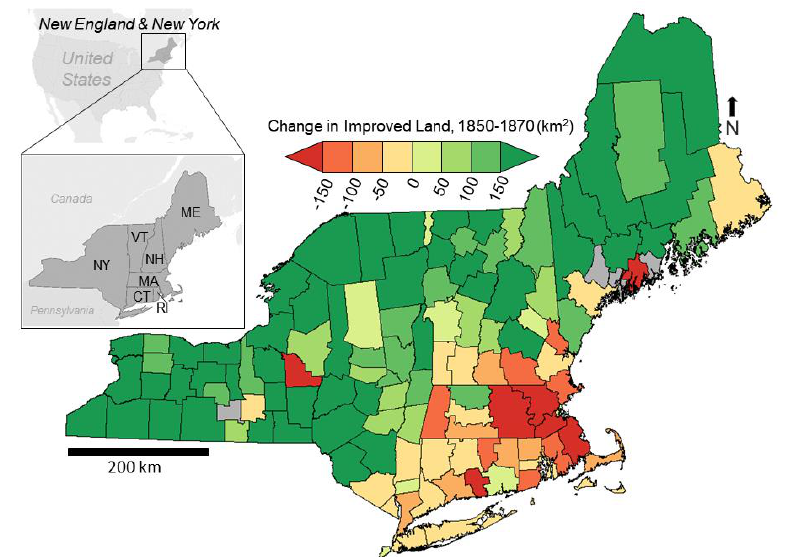
Figure 1. Change in improved land (km 2 ) in the northeastern U.S. by county, 1850–1870, compiled from U.S. Census Nonpopulation Schedule for Agriculture data [29,30]. This census recorded the amount of improved and unimproved farmland at the town level beginning in 1850. Counties in gray did not exist in 1850 and therefore continuous data are not available. Map projection is NAD 1983 UTM Zone 18N. Abbreviations for states in the inset map are as follows: CT, Connecticut; MA, Massachusetts; ME, Maine; NH, New Hampshire; NY, New York; RI, Rhode Island; VT, Vermont.